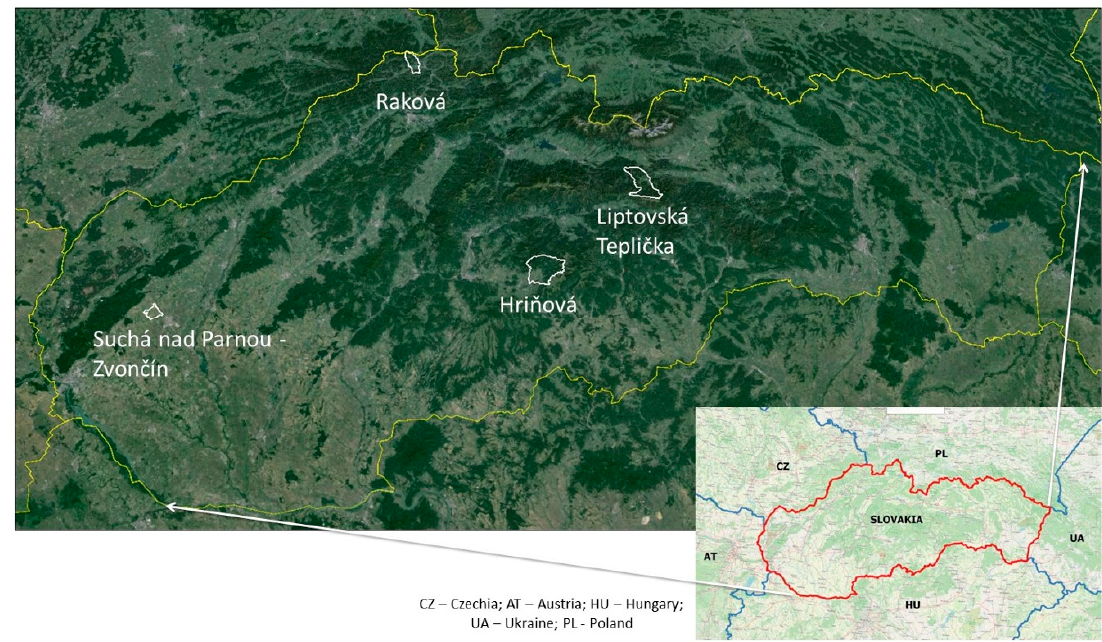
Figure 1. Geographical position of the selected study areas in Slovakia.